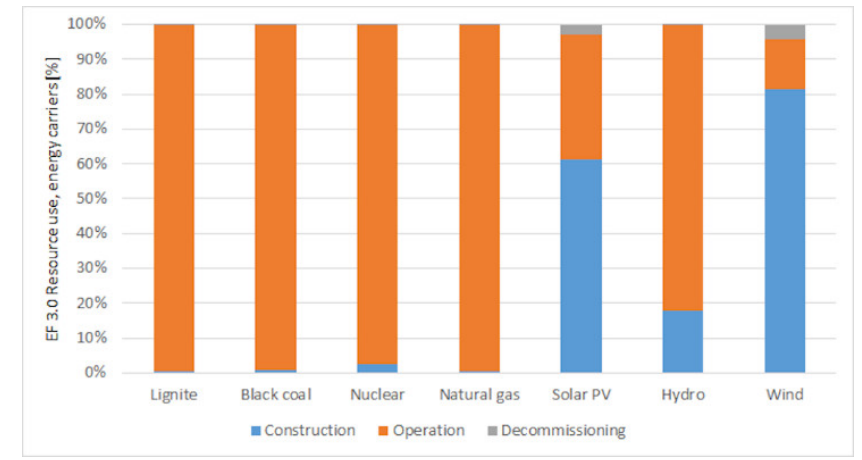
Figure 5. Contributions of the various life cycle phases (construction, operation and decommissioning) of electricity sources to the resource use, energy carriers category. Environmental benefits excluded.